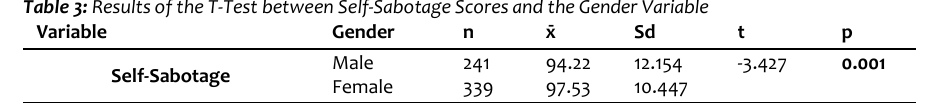
Table 4: Results of the ANOVA between the Self-Sabotage Scores of the Students and Their Faculties Variable Variance Source Self-Sabotage